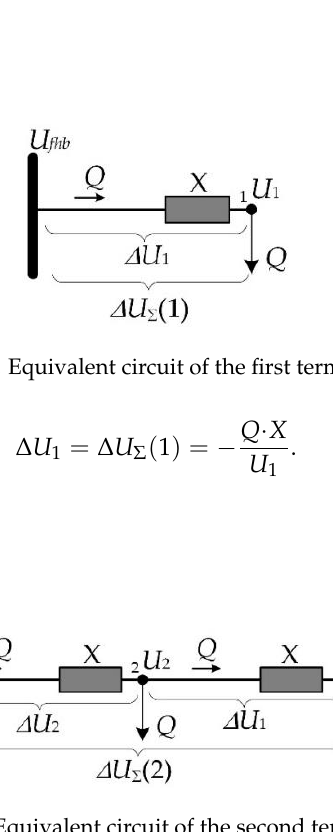
Figure A2. Equivalent circuit of the second term of (10). Δ𝑈 = − 2∙𝑄∙𝑋 2 𝑈 2